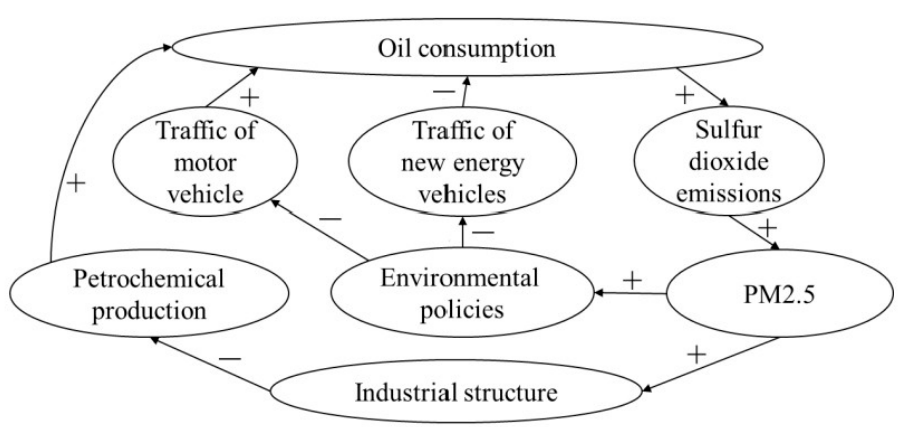
Figure 4. Causality diagram of Beijing crude oil consumption system.